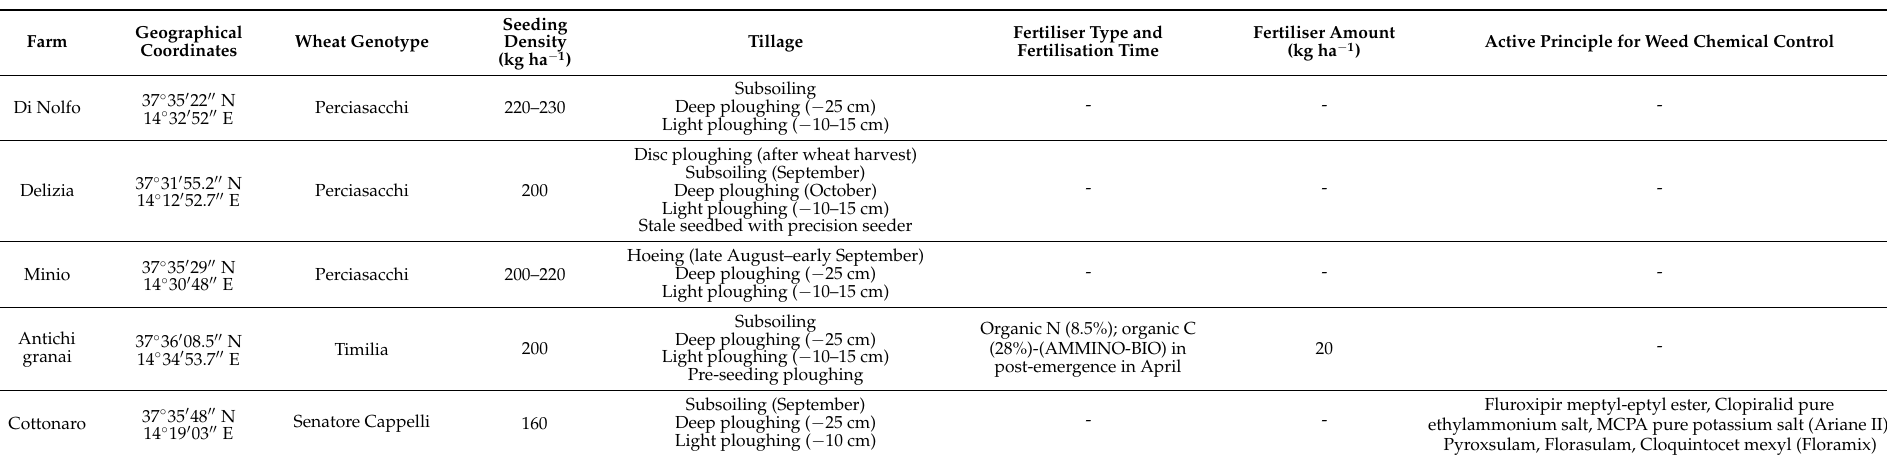
Table 7. Geographical coordinates and agronomic management of the 5 farms belonging to the OLD